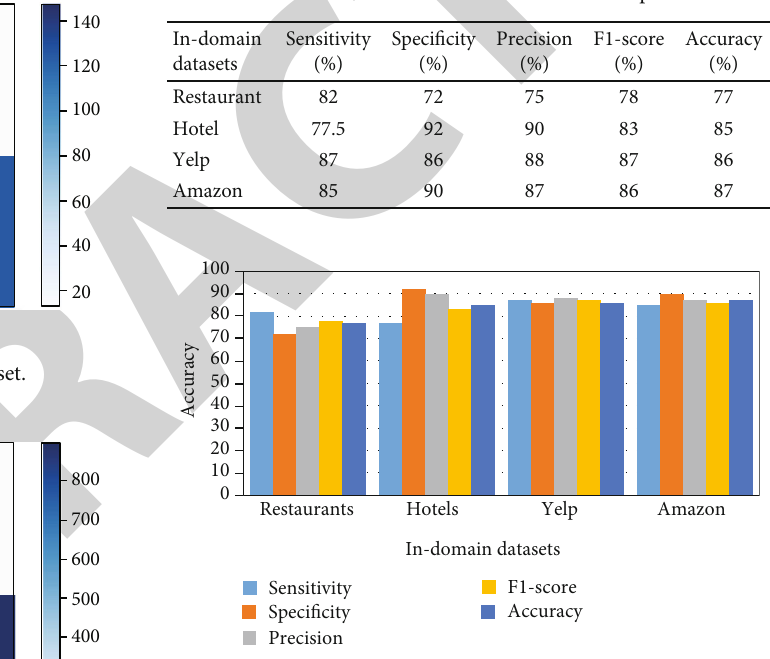
Figure 8: Visualization of the classi fi cation results for in-domain experiment.